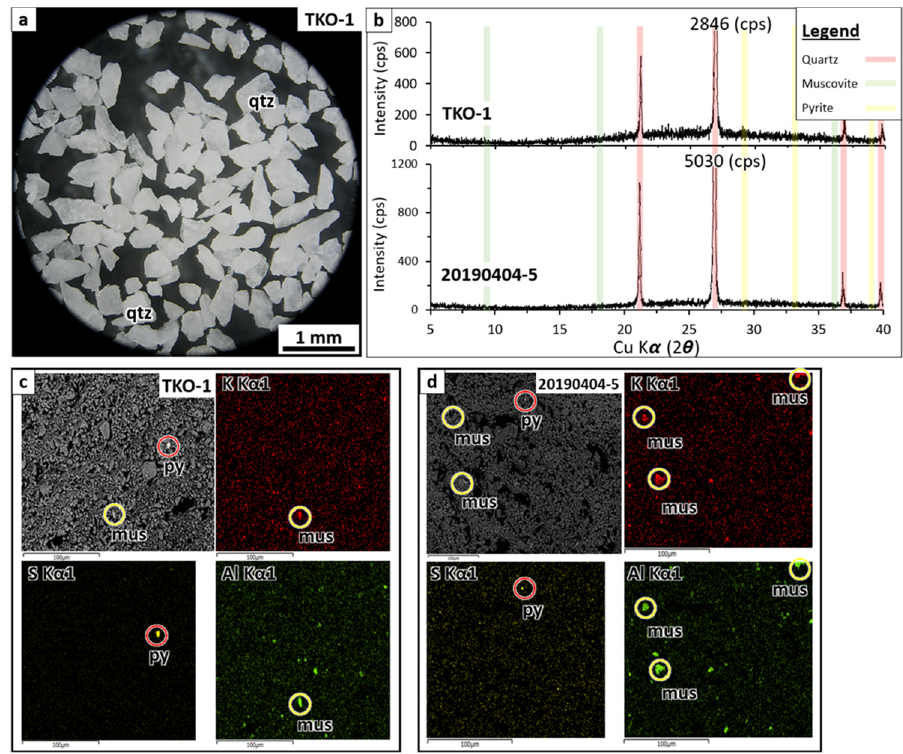
Figure 2. ( a ) Photo of quartz separate fractions; ( b ) X-ray diffraction patterns of quartz separate samples; ( c , d ) elemental mapping of quartz separate samples under a scanning electron microscope showing the negligible impurities of associated minerals, such as muscovite (mus) and pyrite (py). To test the purity of the quartz separates, X-ray diffraction (XRD) spectra were collected using a Rigaku Multiflex X-ray diffractometer with a Cu-K α tube (30 kV, 16 mA, receiving slit = 0.3 mm, step = 0.01, 2 ◦ 2 θ /min) at Akita University. The results show almost pure